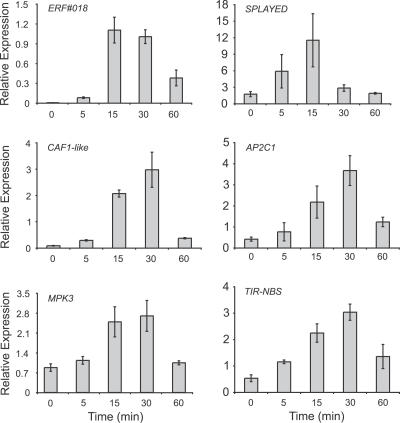
Selected RWR Genes Displaying a Rapid and Transient Expression Following Mechanical WoundingTotal RNA was extracted from 3-wk-old mechanically wounded tissue and subject to RT-qPCR analysis. ERF#018, CAF1-like, AP2C1, MPK3, and TIR-NBS transcripts were normalized to the 60S ribosomal protein L14 while SPLAYED transcripts were normalized to TIP41-like measured in the same samples. Data are means of n = 3 ± SEM.